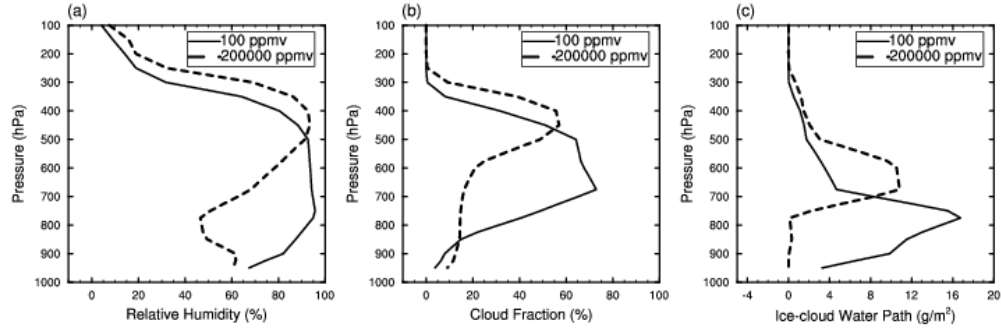
Fig. 3. Vertical distributions of relative humidity (a) , cloud fraction (b) , and ice-cloud water path (c) , averaged between 30 ◦ S and 60 ◦ S. Figure 3. Vertical distributions of relative humidity (a), cloud fraction (b), and ice-cloud water path (c), averaged between 30 ºS and 60 ºS.